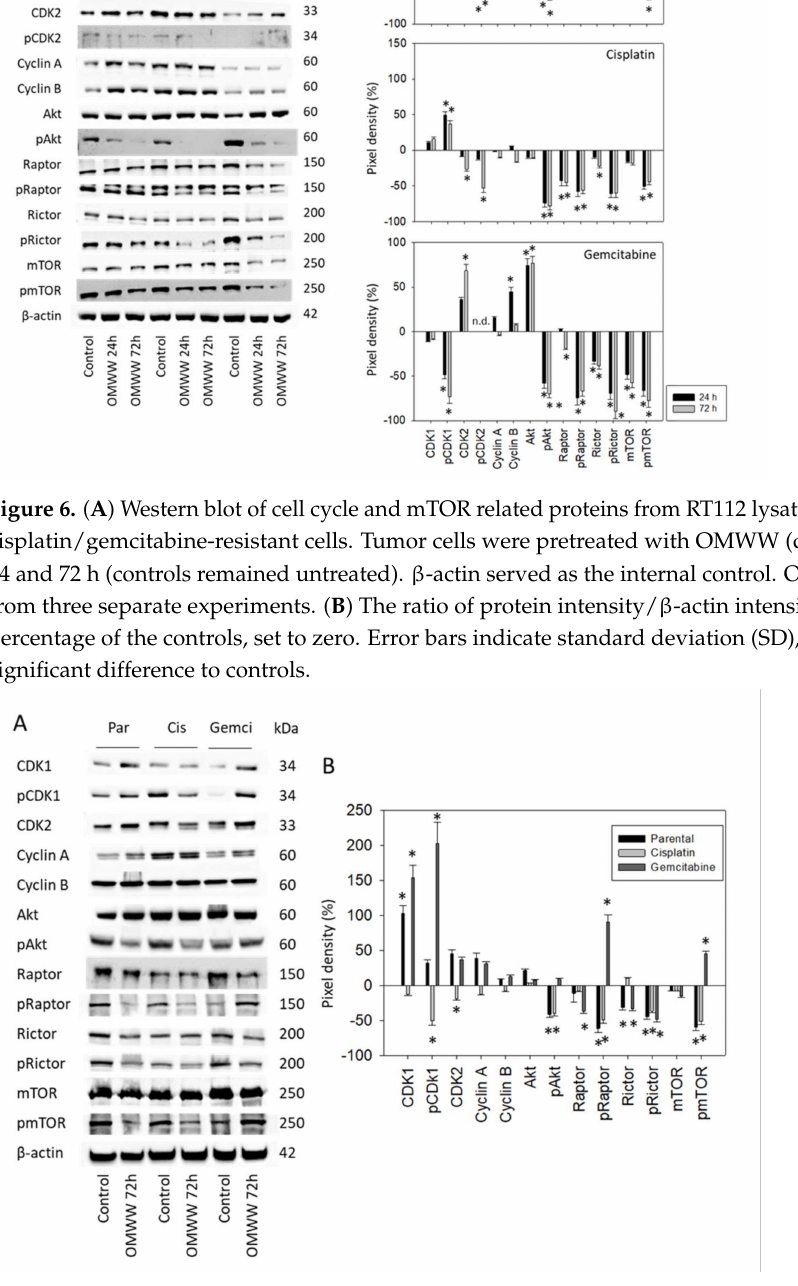
Figure 7. ( A ) Western blot of cell cycle and mTOR related proteins from lysates of parental and cisplatin/gemcitabine-resistant T24 cells. Tumor cells were pretreated with OMWW (dilution 1:125) for 72 h (controls remained untreated). β -actin served as the internal control. One representative from three separate experiments. ( B ) The ratio of protein intensity/ β -actin intensity expressed as a percentage of the controls, set to zero. Error bars indicate standard deviation (SD), n = 3. * indicates significant difference to